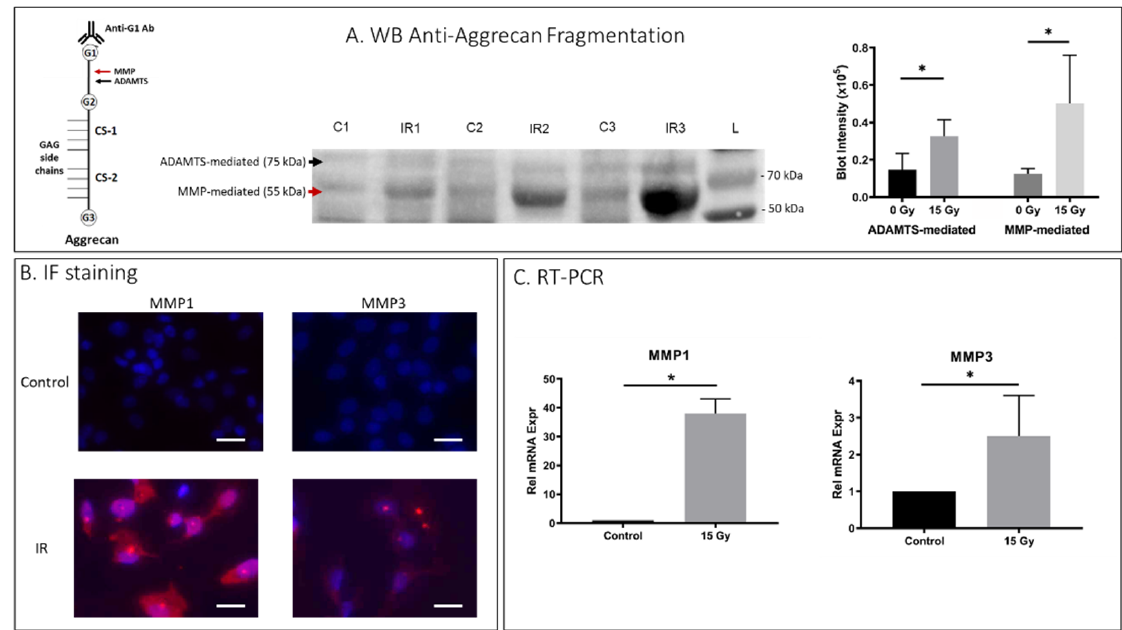
Figure 2. IR treatment increased matrix breakdown in rat AF cells. Rat AF cell cultures were treated with 15 Gy IR and incubated for 5 days to establish senescence. ( A ) Western blot (WB) analysis of anti-aggrecan fragmentation from 3 control and 3 IR AF samples showed elevated anti-aggrecan fragmentation mediated by ADAMTS (75 kDA) and MMP (55 kDa) in IR-treated AF cell samples. “C” designates controls, “IR” designates ionizing radiation treated, and “L” designates protein ladder. Left side, a schematic representation of aggregate consisting of the core aggrecan protein bound to GAG side chains at the chondroitin sites (CS-1, CS-2), and the MMP- and ADAMTS-mediated cleavage site within the interglobular domain residing between the G1 and G2 domain of aggrecan are indicated with arrows. Right side, quantification of western blot band intensity is depicted in graphs on right. ( B ) IF staining demonstrated elevated MMP1 and MMP3 protein expression (red) in IR-treated AF cells compared to untreated cells. ( C ) qRT-PCR also confirmed elevated MMP-1 and -3 gene expression in IR-treated AF cells compared to untreated cells. Data shown as an average of n = 3 with one standard deviation. On microscopic images, the white bar for scale measures 20 µ m. * p ≤ 0.05.